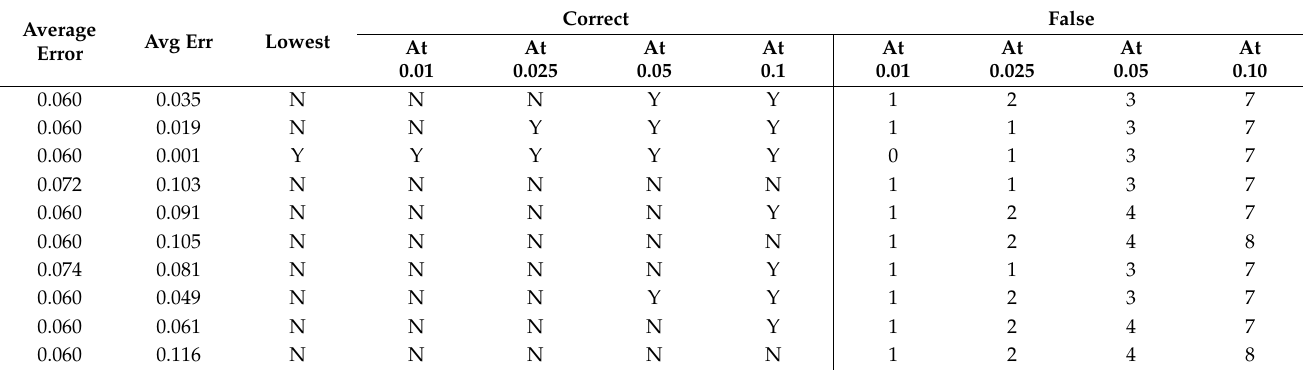
Table A139. Set 2, trials 31–40 summary data (all 0.5 PR